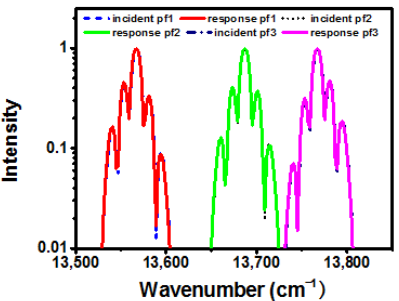
Figure 15. CARS intensities in air and the disk-ring structure at the step positions of 12,387, 12,267, and 12,187 cm − 1 of the Stokes laser, normalized with their own maximum, respectively.